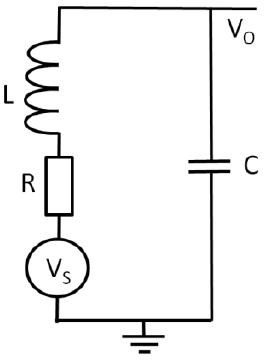
Figure 5. Equivalent circuit of the resonant circuit.